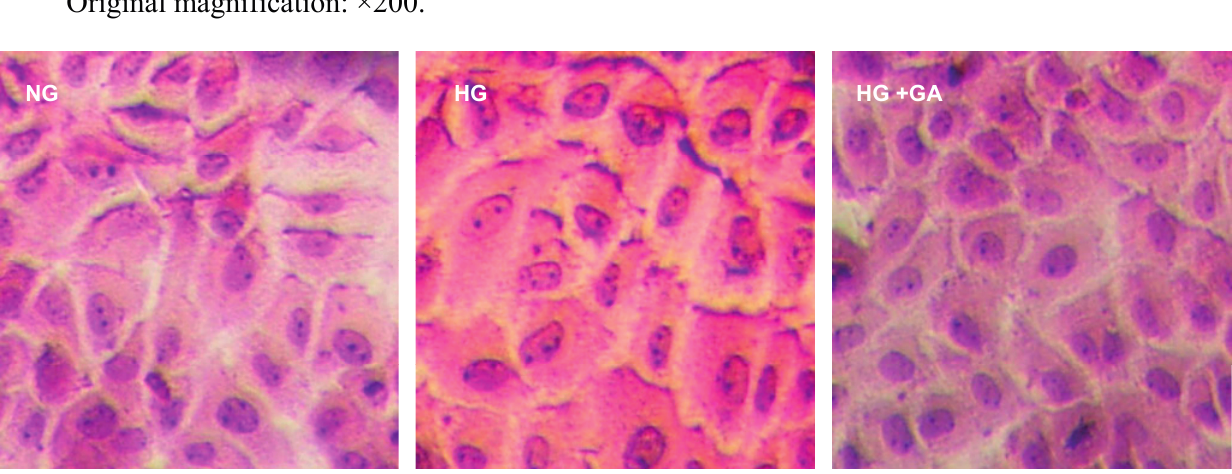
Figure 3. Effect of GA on cell morphology induced by HG in NRK-52E cells. The cells were incubated in the three groups for 24 h. They were stained with hematoxylin-eosin. Original magnification: ×200.